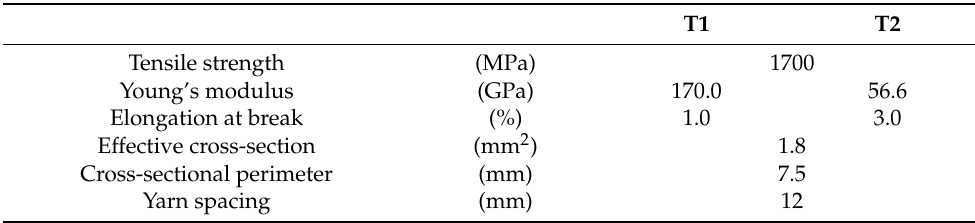
Table 2. Mechanical and geometric properties of the continuous reinforcement adopted in the numerical simulations.